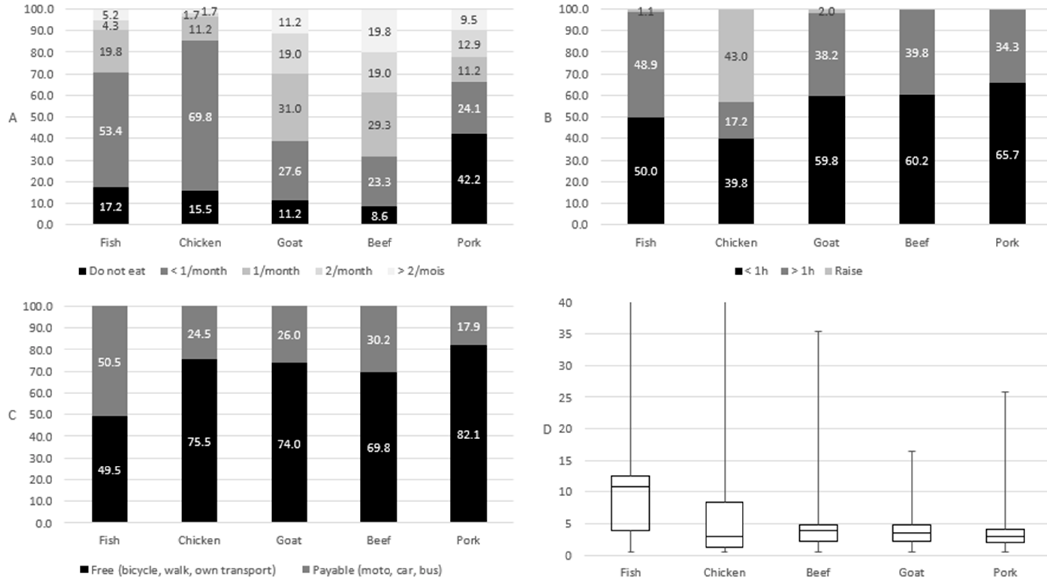
Figure A7. Frequency of domestic animal protein consumption ( A ); access time to domestic animal protein among consumers who eat, buy, and raise domestic animals ( B ); access mean to domestic animal protein among consumers who eat and buy domestic animals ( C ); Euclidian distance (kilometer) to domestic animal protein among consumers who eat and buy domestic animals ( D ) around Sebitoli area, Kibale National Park, Uganda.